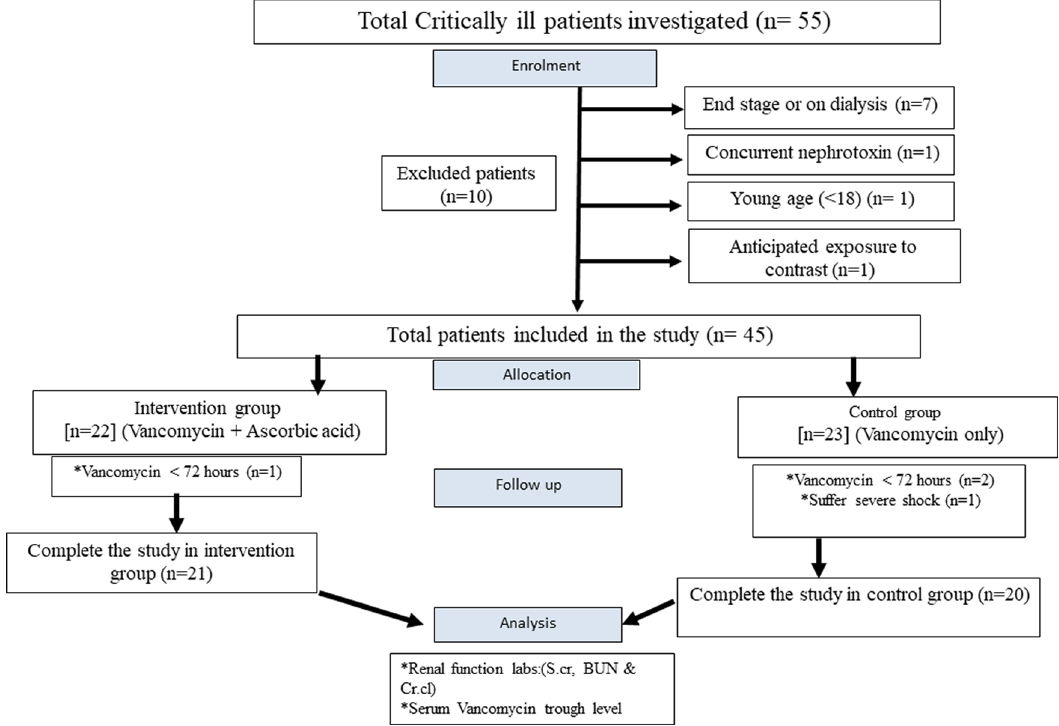
Figure 1. Detailed CONSORT flow diagram of the study. Abbreviations: S.cr, serum creatinine; BUN, blood urea nitrogen; Cr.cl, creatinine